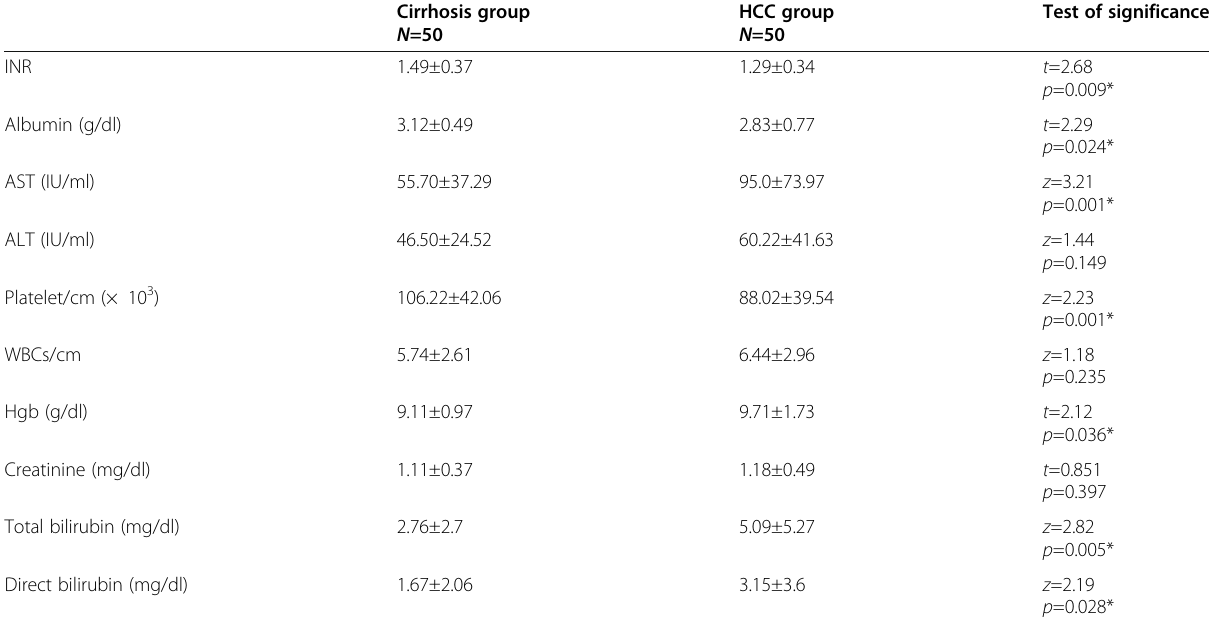
Table 3 Laboratory results of the studied groups